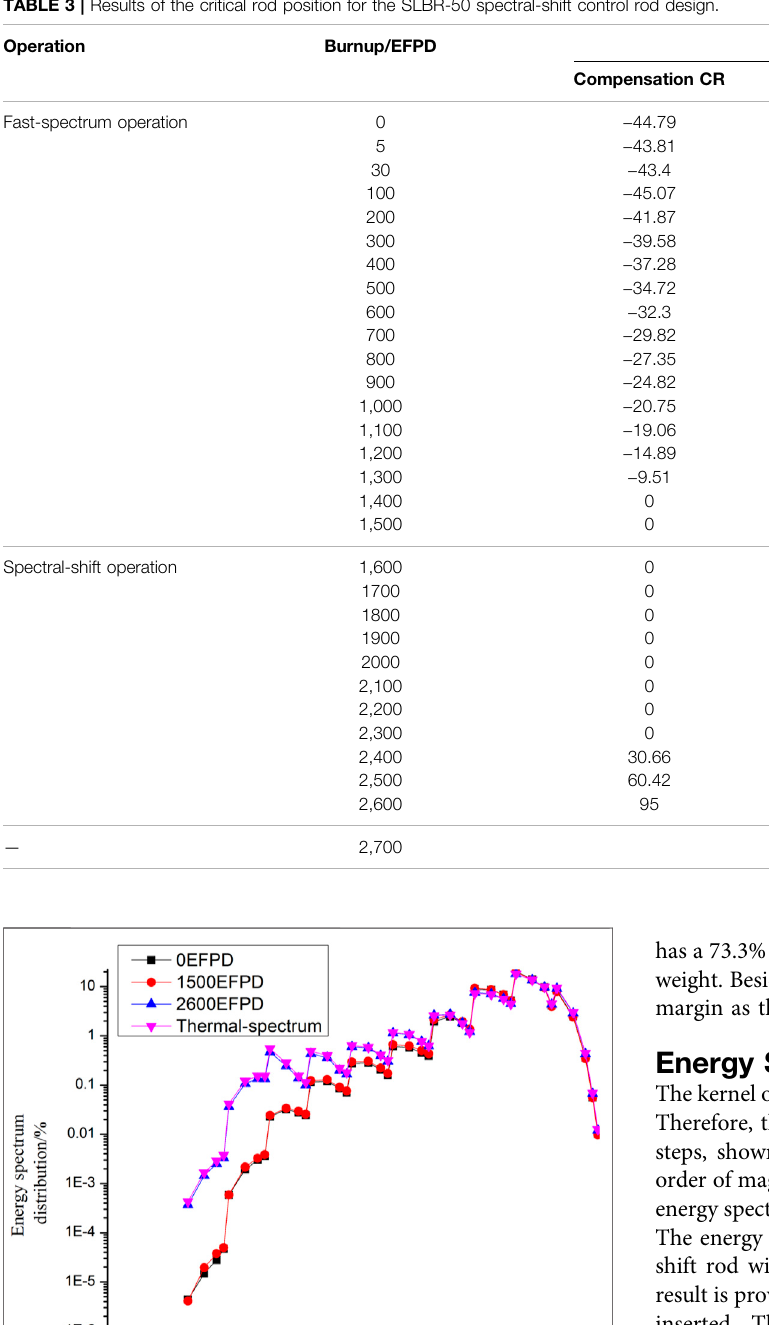
Frontiers in Energy Research |